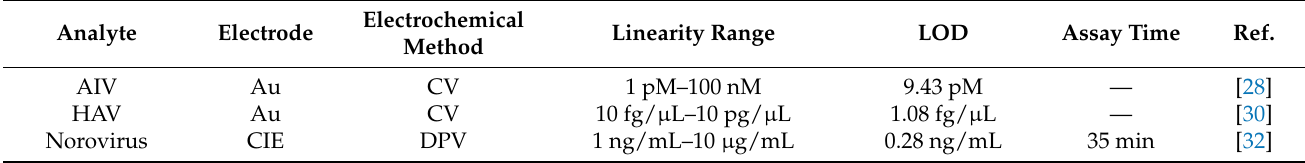
Table 2. Electrochemical biosensors for virus detection.